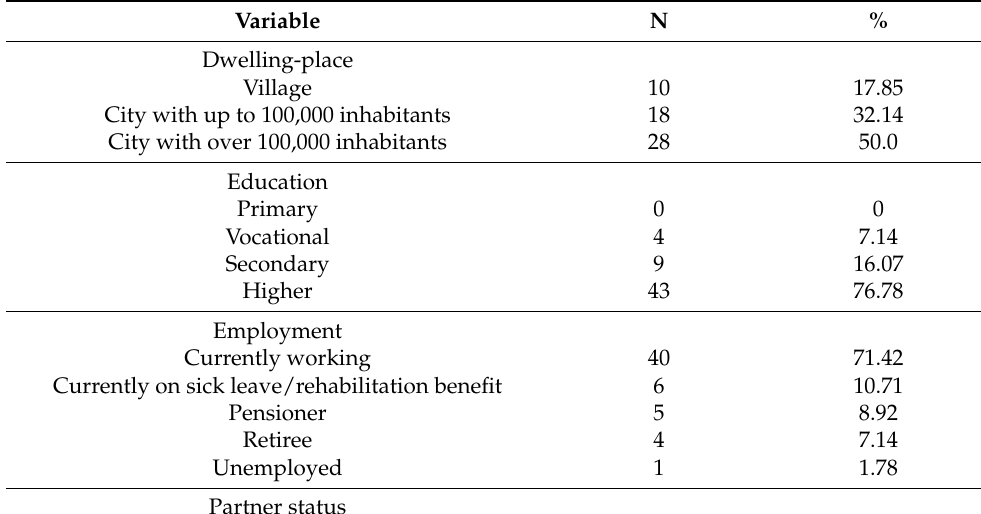
Table 1. Table 1. Demographic